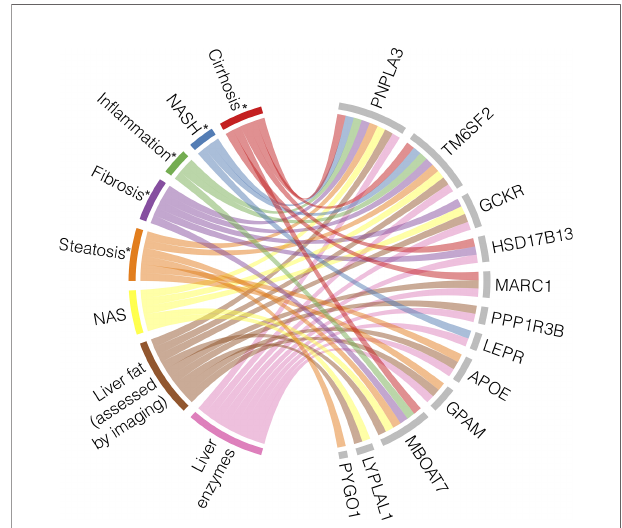
FIGURE 2 | Heterogeneity and pleiotropy of genes associated with NAFLD phenotypes. Loci with their corresponding genes which have been shown to be associated with NAFLD through genome- and/or exome-wide association studies are displayed on the right side of the chord diagram, indicated by grey bars. On the left side of the diagram are the NAFLD states with their associated measurements, each represented by a different color. Each ribbon represents a signi fi cant association identi fi ed between each gene and the described state. * indicates histologically de fi ned state (56, 80, 82, 84 – 87, 89 –